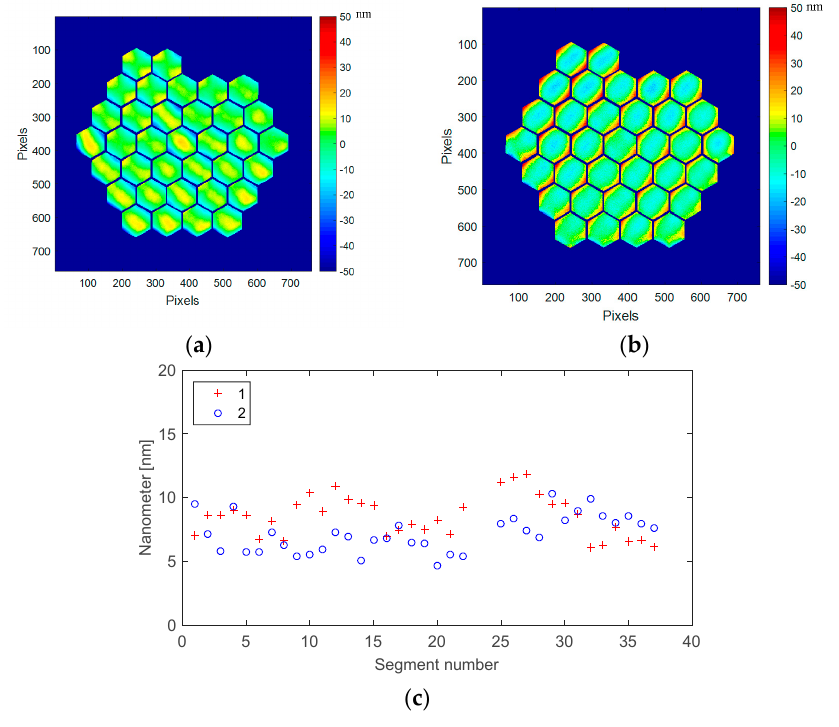
Figure 16. DM segments surface deformation: ( a ) At ambient (293 K), 5 nm RMS, 24 nm PtV; ( b ) At 160 K 8 nm RMS, 47 nm PtV; ( c ) Surface deformation by segments at ambient (values 2 in blue) has a mean value of 7.2 nm with a standard deviation of 1.5 nm, and at 160 K (values 1 in red), a mean value of 8.5 nm with a standard deviation of 1.6 nm.